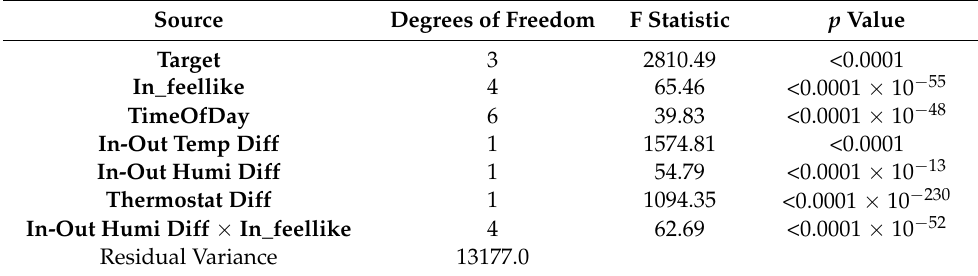
Table 7. The results of two-way ANOVA based on ampere-fixed